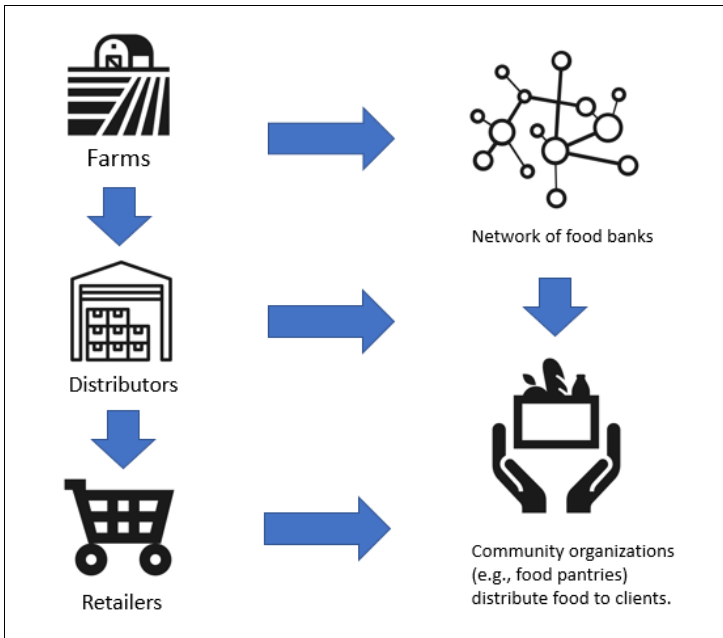
Figure 1. Sources of Fresh Produce for Food Banks and Clients Farms, aggregator/distributors, and retailers can donate or sell produce directly to community organizations for distribution to clients. More often, these donations are managed by regional food banks with the capacity to receive, hold, and distribute perishable